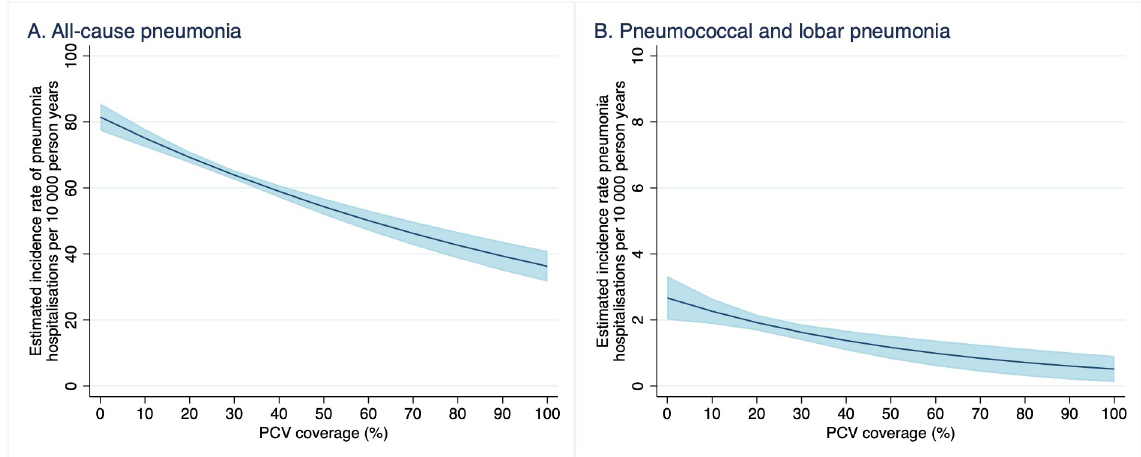
Fig 6. Estimated rate of pneumonia hospitalisation and 95% CIs (blue shading) among undervaccinated children at each decile of PCV coverage, New South Wales and South Australia, 2001–2012. CI, confidence interval; PCV, pneumococcal conjugate vaccine.